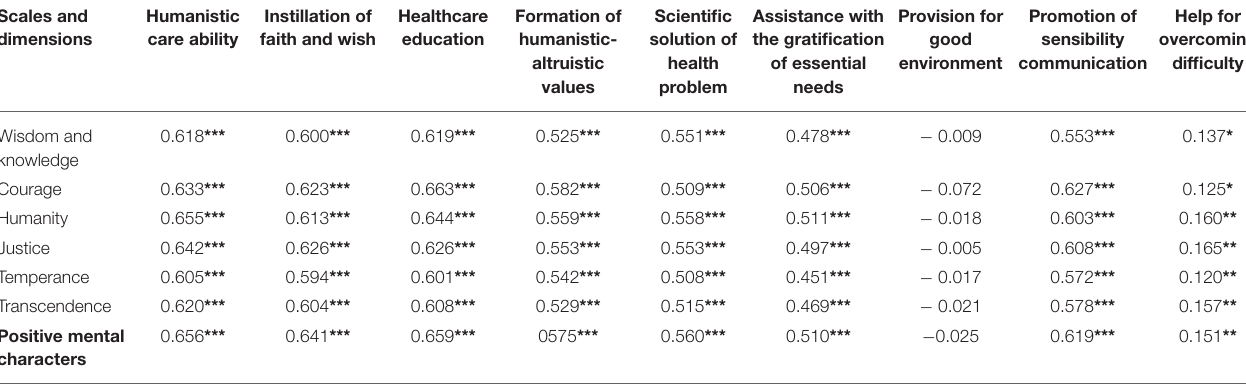
TABLE 3 | Correlation coefficients between positive mental characters and humanistic care ability of nursing students. Scales and